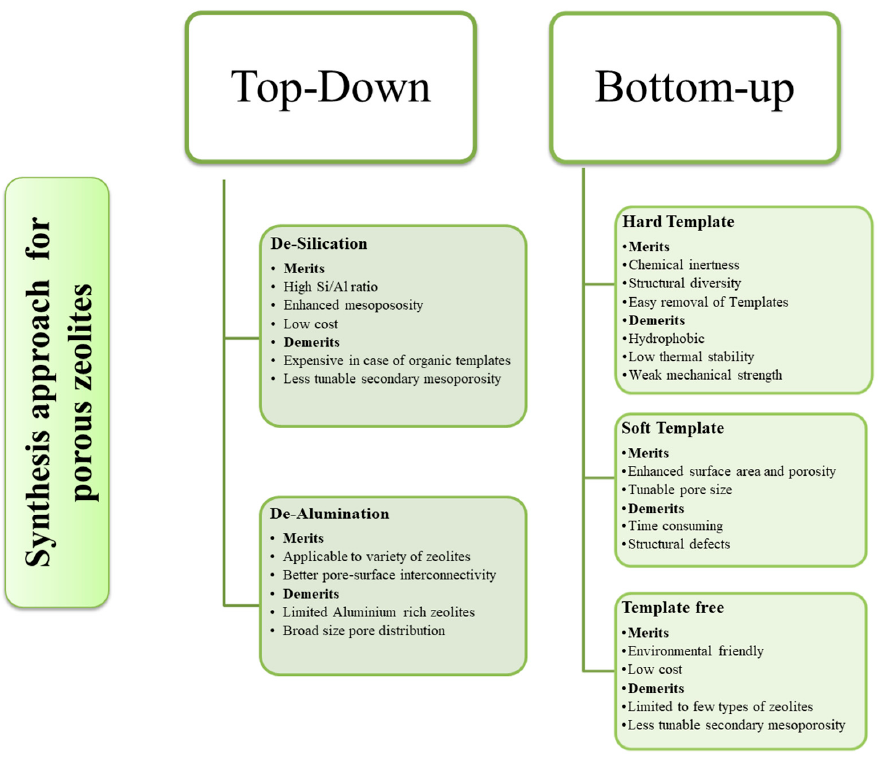
Figure 4. Advantages and disadvantages of bottom-up and top-down strategies for the synthesis of porous zeolites.